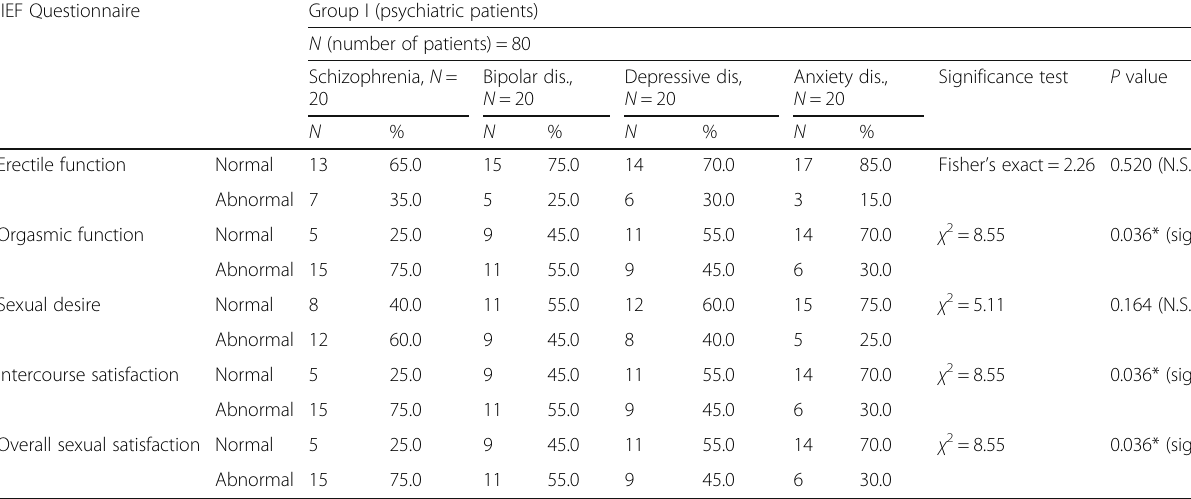
Table 6 Patterns of sexual functions among patients of group I (psychiatric patients) IIEF